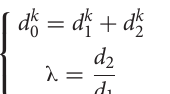
The blood flow distribution in the vascular tree in Figure 2B can be analogous to a one-dimension graph as shown in Figure 2C . The gray segments indicate the range of the graph and the black segments reflect the blood flow in vessel segments. Each bisection corresponds to a bifurcation of the vascular tree and divides this geometrical structure into smaller